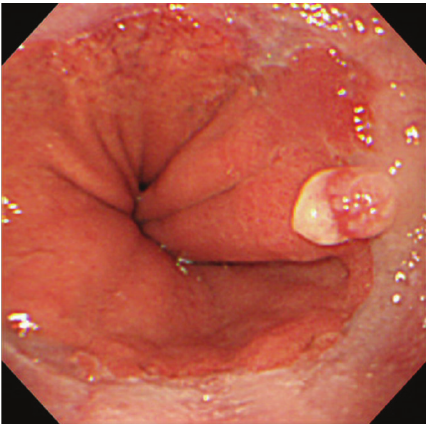
Figure 1: Endoscopic view of a polyp at the esophagogastric junction at the initial disease presentation.